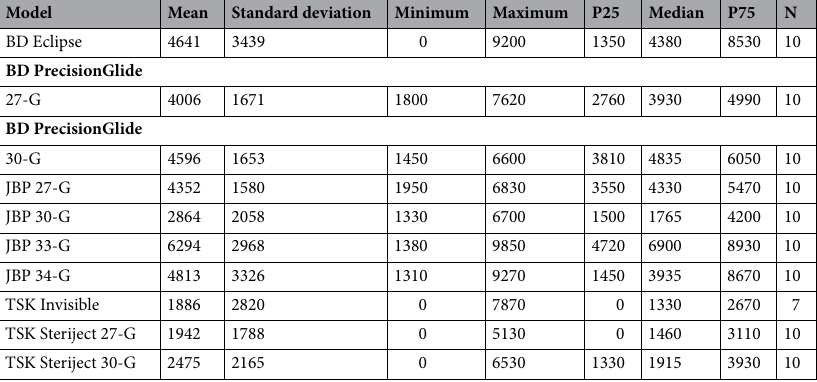
Table 2. Summary of particle numbers/mL by needle model.